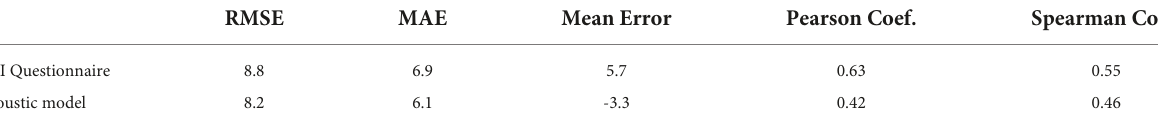
TABLE 5 Accuracy of the acoustic model and BDI questionnaire. RMSE MAE Mean Error Pearson Coef. Spearman Coef.